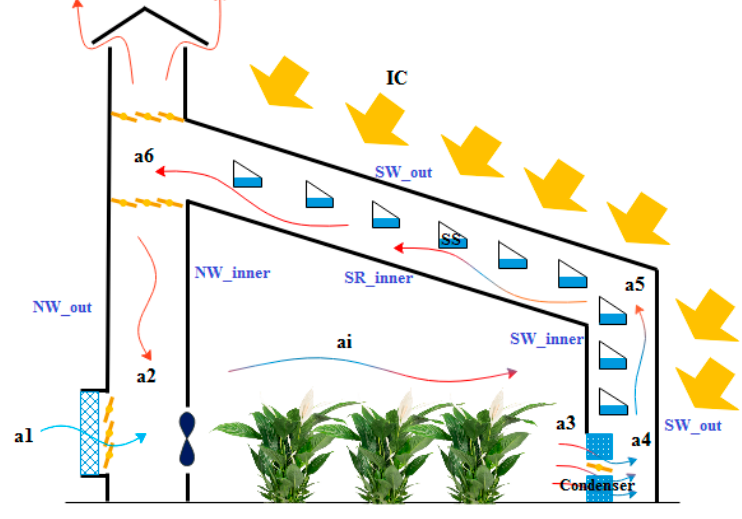
Figure 21. Egypt GH structure [61].